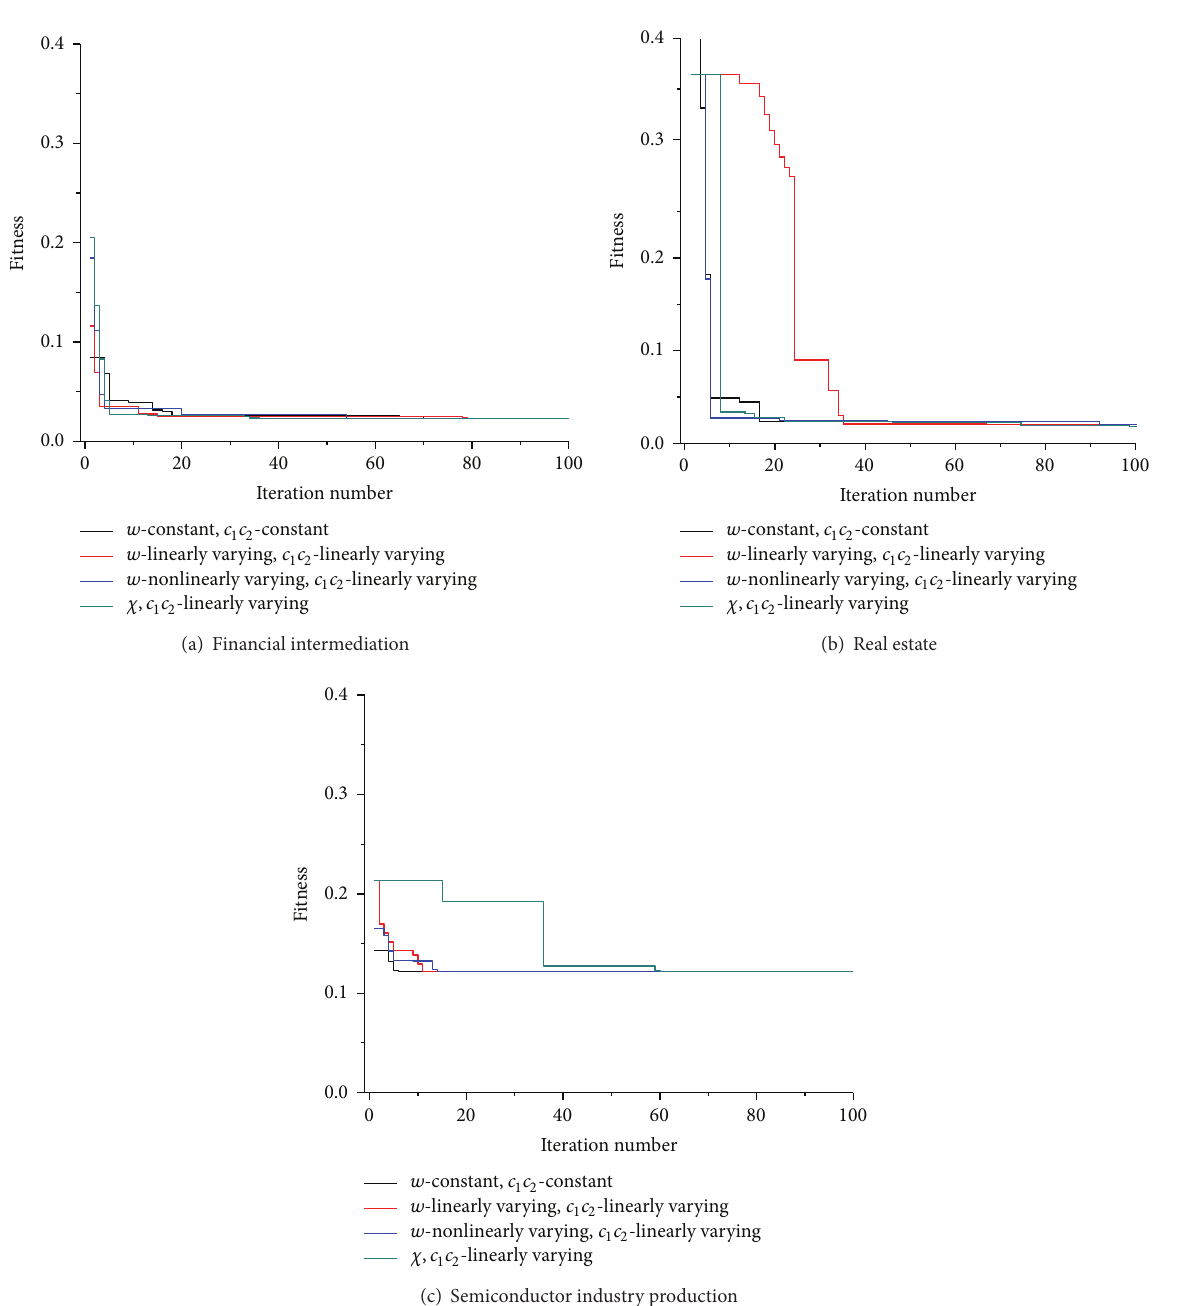
Figure 2: The convergence speed comparison of the fitness values among PSOs with various parameter setting methods.